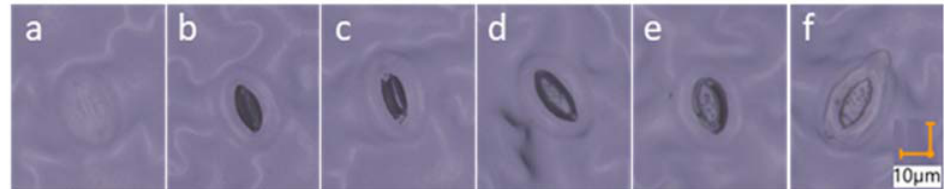
Figure 2. Model images of lettuce stomata positive imprints measured by image analysis using a digital 4K microscope. Images ( a – f ) show the increasing opening of the stomatal pore. Images scale: 10 μ m.